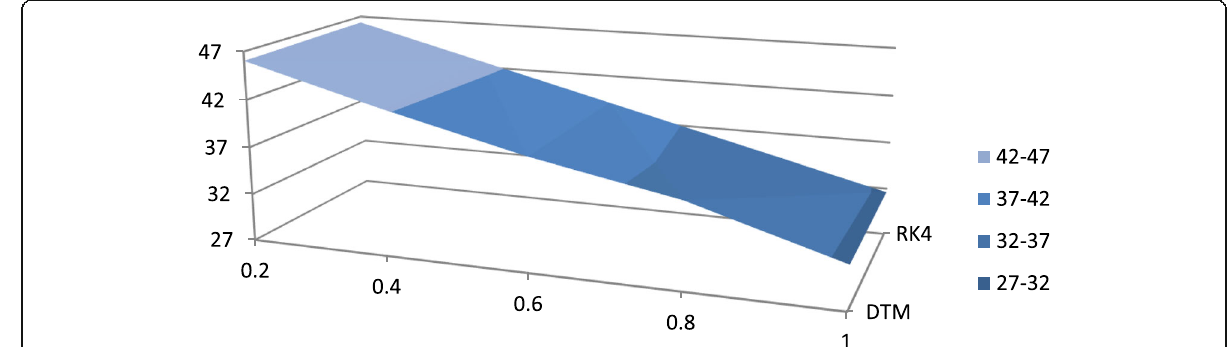
Fig. 17 Description of the behavior of the recovered